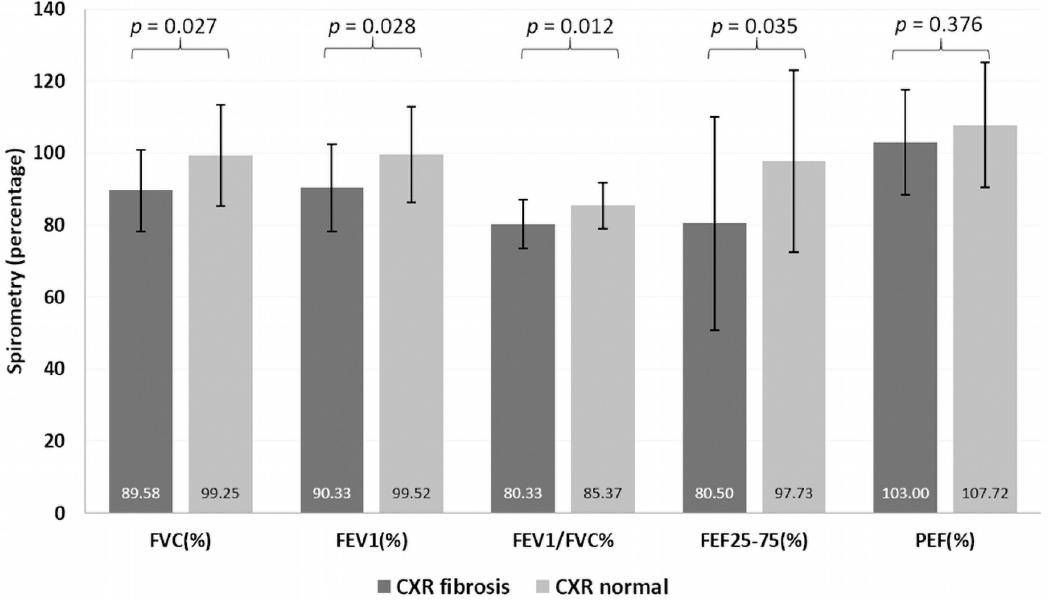
Fig 2. Correlation between residual lung fibrosis on chest radiograph and